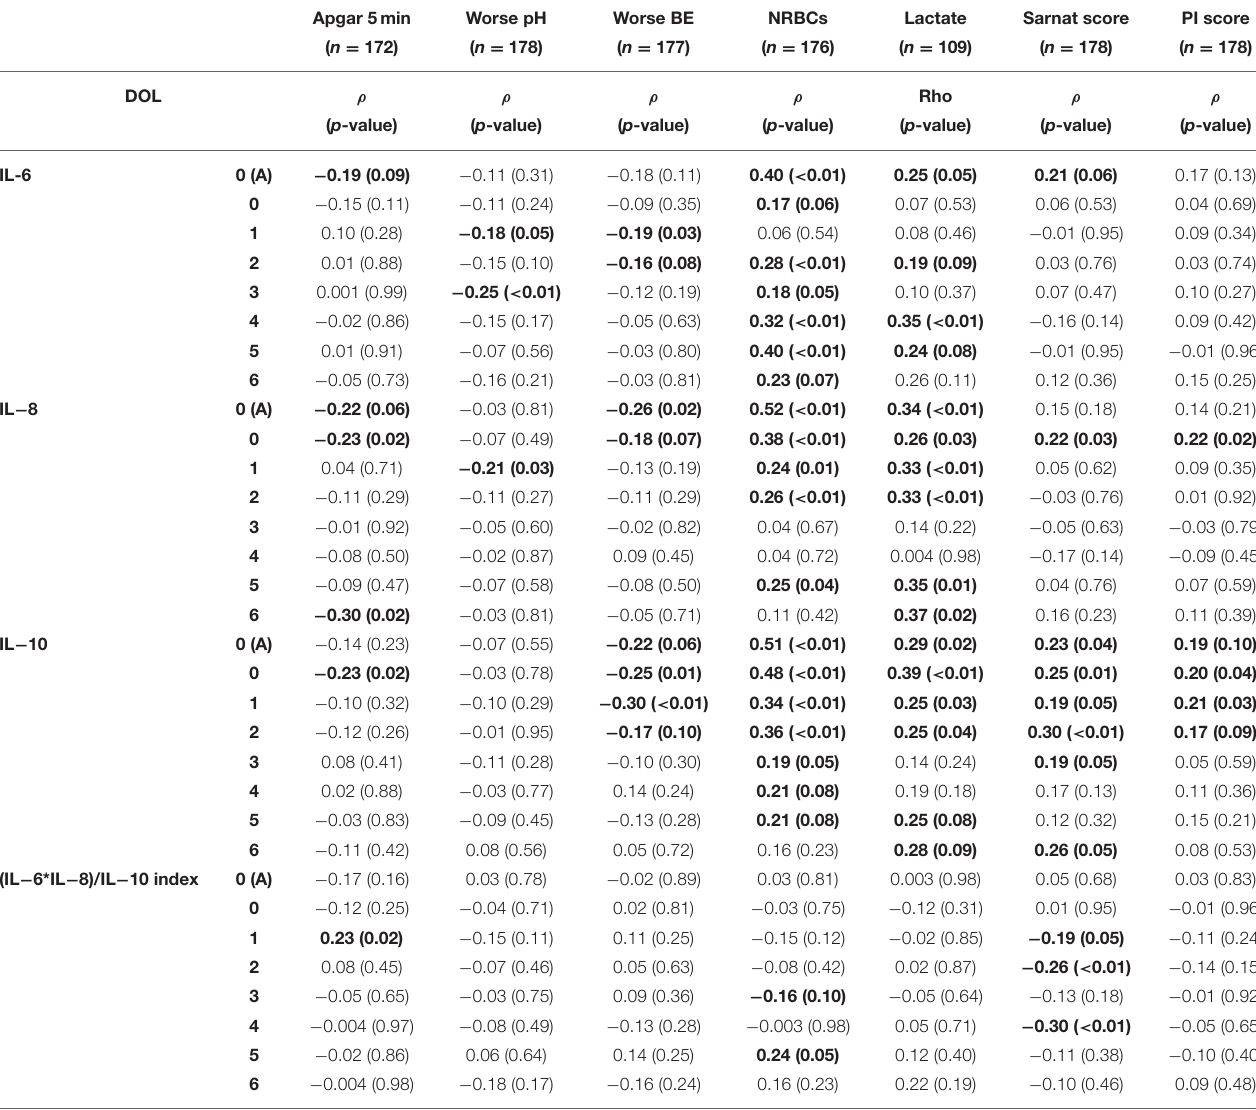
TABLE 4B | Correlation between indicators of HI severity and cytokines during the first week of life. Apgar 5min Worse pH Worse BE NRBCs